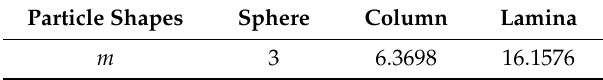
Table 1. Shape factor values for various nanoparticle shapes